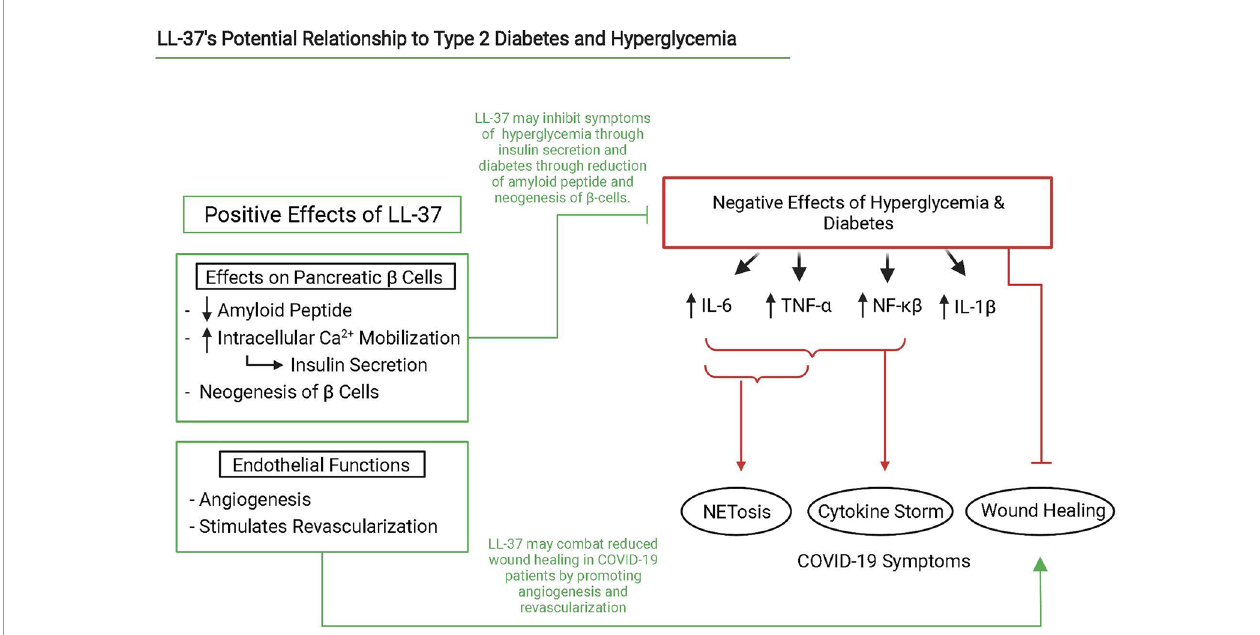
FIGURE 3 | Interaction scheme of LL-37, NETosis, hyperglycemia, and diabetes that lead to severe COVID-19 symptoms. Relevant interactions are cited below. Created with